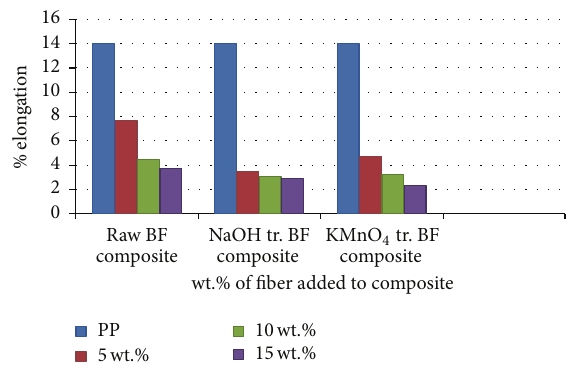
Figure 5: Comparison of % elongation of raw and treated BBF/PP composites.